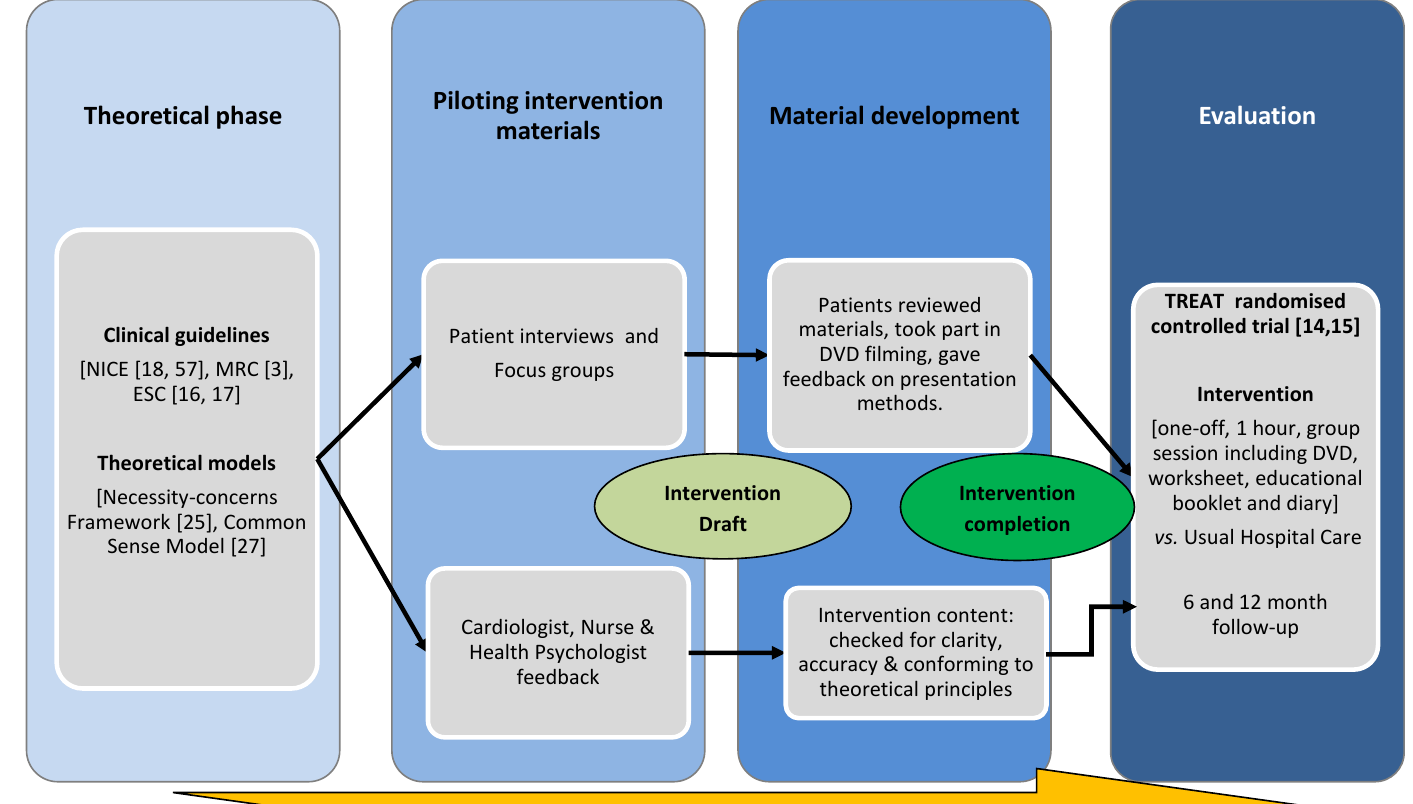
Figure 1. Intervention development process.